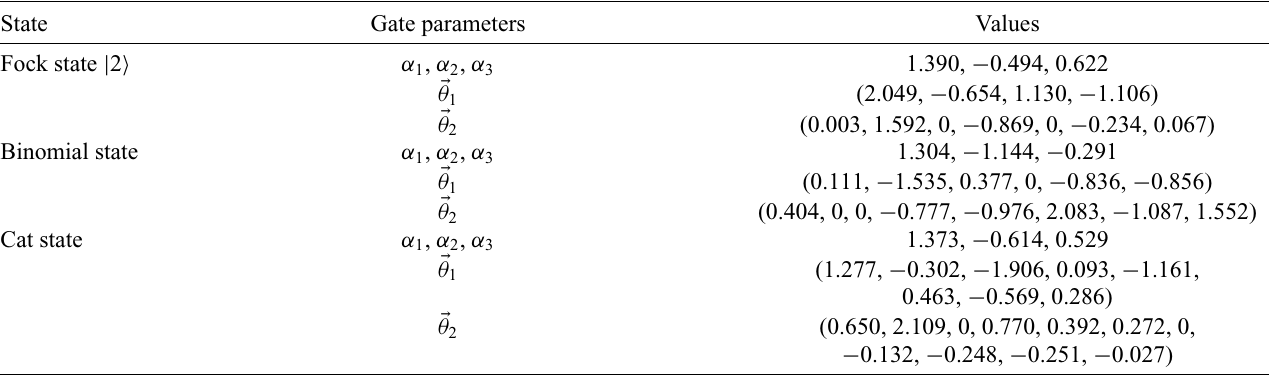
TABLE III. Gate parameters used to create the states in Figs.